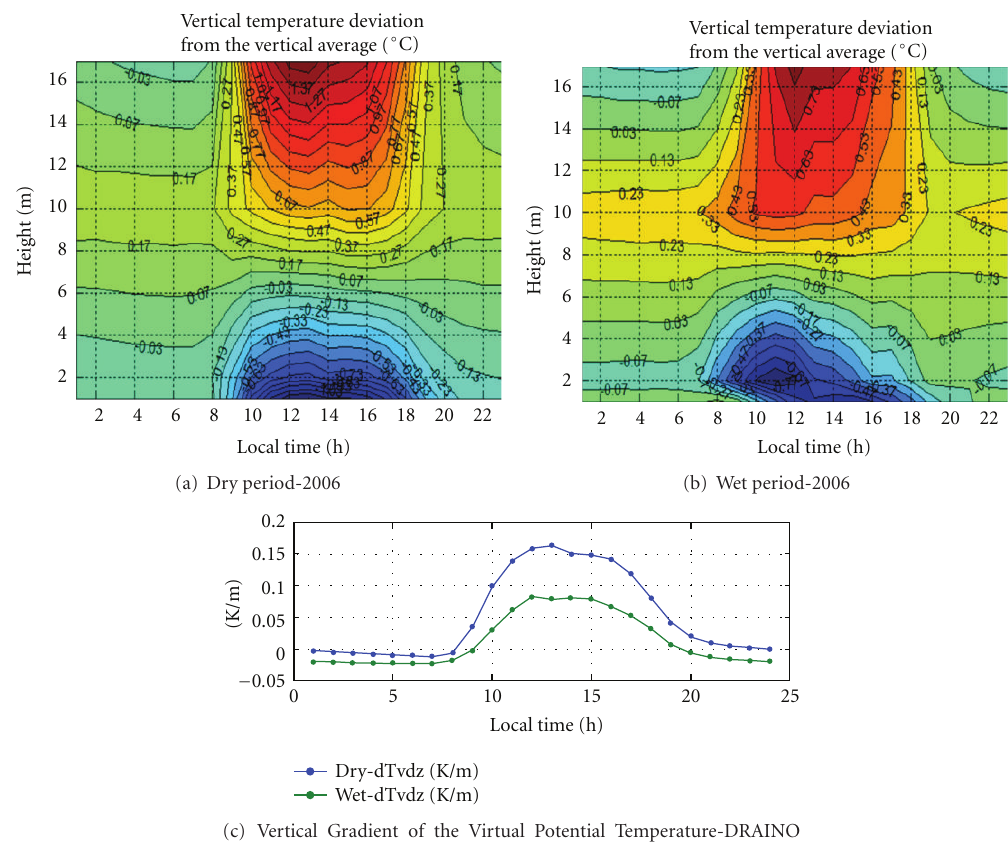
Figure 9: Daily course of the vertical deviation of the virtual potential temperature for dry (a) and wet (b) periods of the year 2006, and the virtual potential temperature vertical gradient (c), over slope area DRAINO system